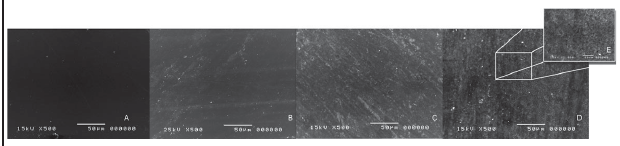
Fig. 3 – Representative SEM micrographs of bovine enamel at baseline (A) and after immersion in antihistamine liquid formulation (Histamin ® ) for 5 min (B), 15 min (C) and 30 min (D). Note the presence of eroded areas at higher magnification (x2000) (E).